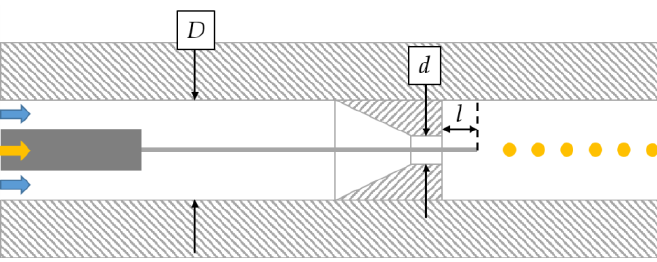
Figure 3. Schematic representation of the droplet generator with steel and fused silica capillary, orifice with diameter d and flow channel with height D . The capillary position is represented by the parameter l .